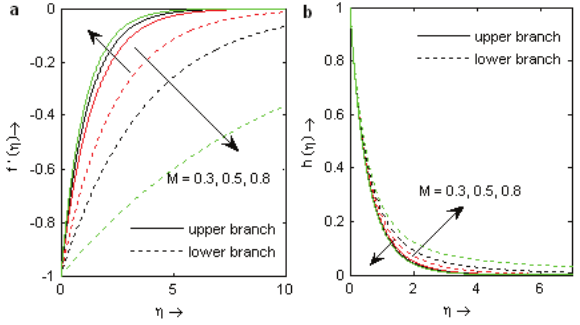
Figure 1. (a) Dual velocity profiles f 0 .(cid:17)/ and (b) dual temperature profiles h ( (cid:17)/ for various values of M with